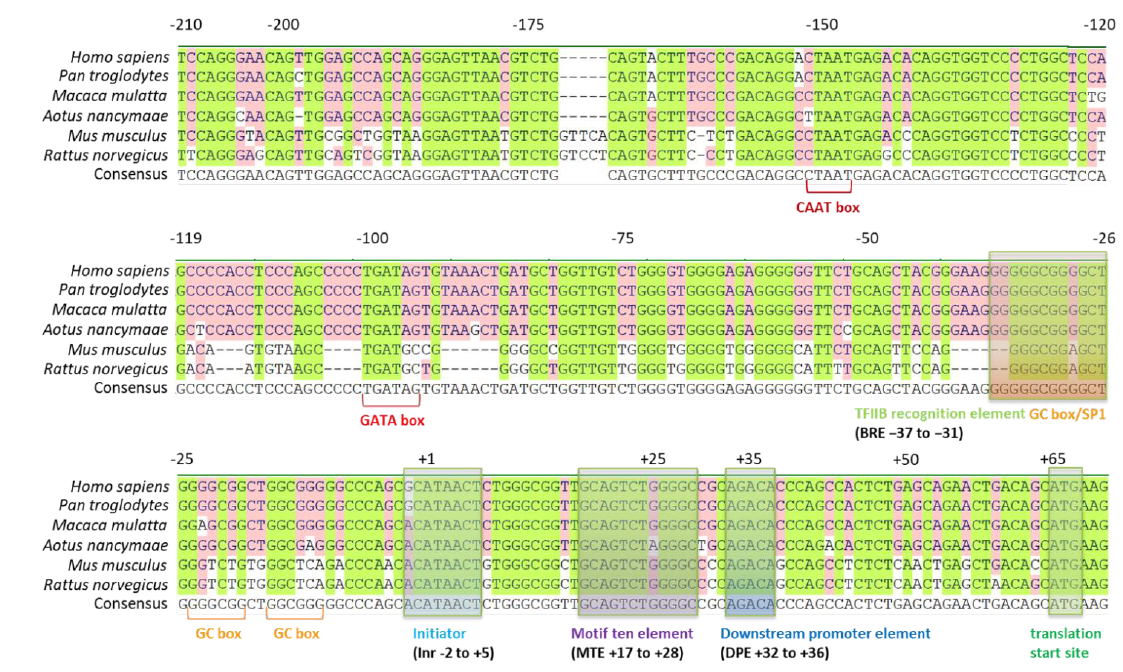
Figure 5. The alignment of the human MFAP4 promoter region with those of other species.